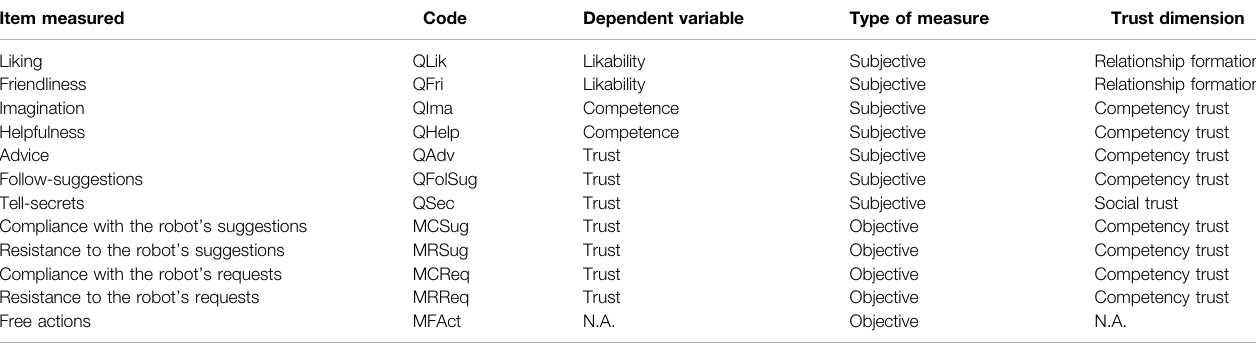
TABLE 1 | Summary of subjective and objective measures and their association with trust dimensions. Item measured